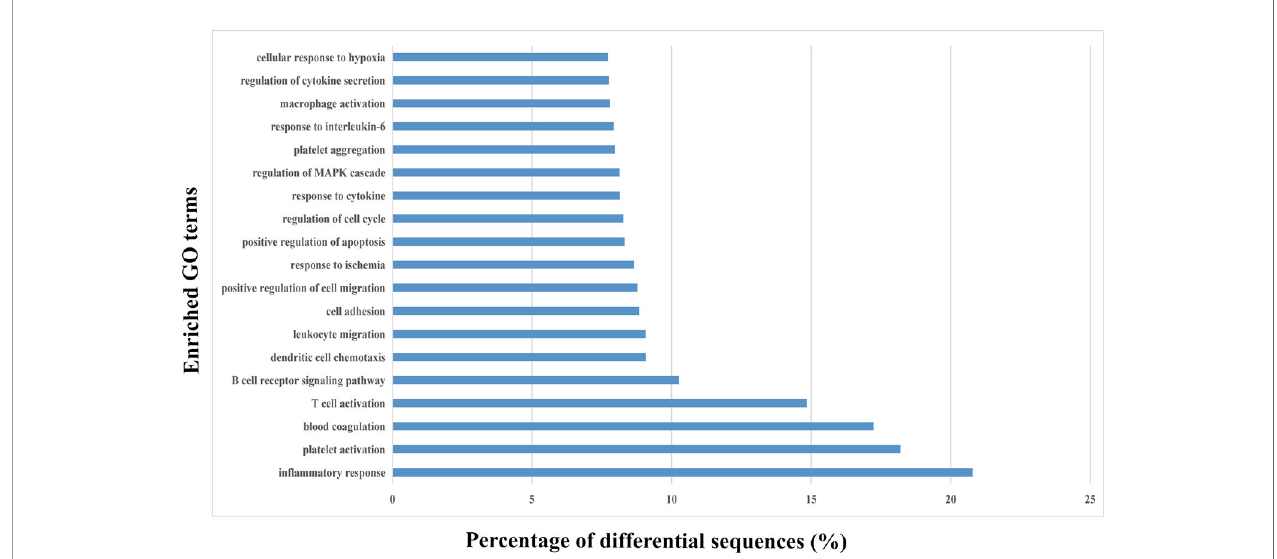
FIGURE 4 | Gene ontology (GO) enrichment analysis of the differentially regulated proteins. The top 20 enriched terms according to the GO functional annotation clustering of the 202 differentially expressed miRNAs in the heat-stroked hepatocyte-derived EVs. Percentages of the sequences involved are shown.